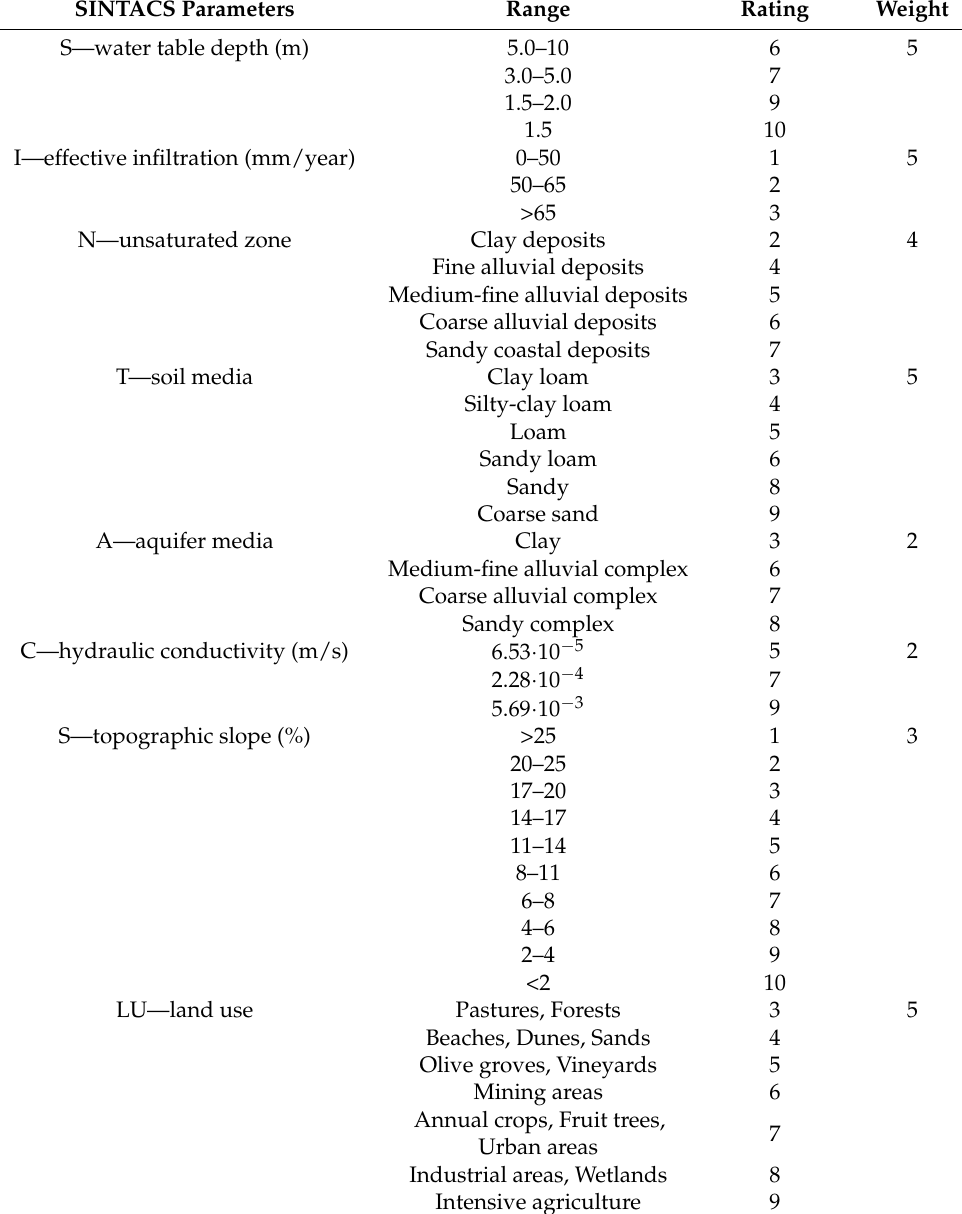
Table 1. Ranges, ratings and weights of SINTACS and SINTACS-LU parameters (modified from [24,25,44]). SINTACS Parameters Range Weight S—water table depth